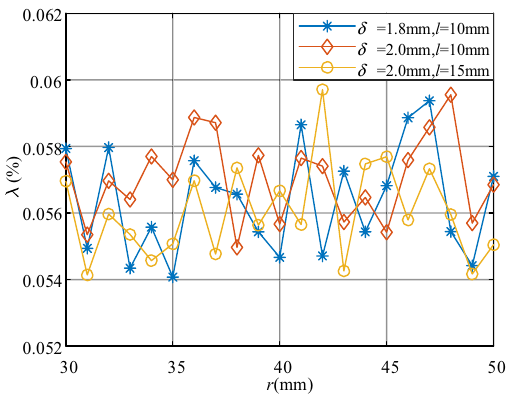
Figure 5. The variation curve of λ for three different group parameters.